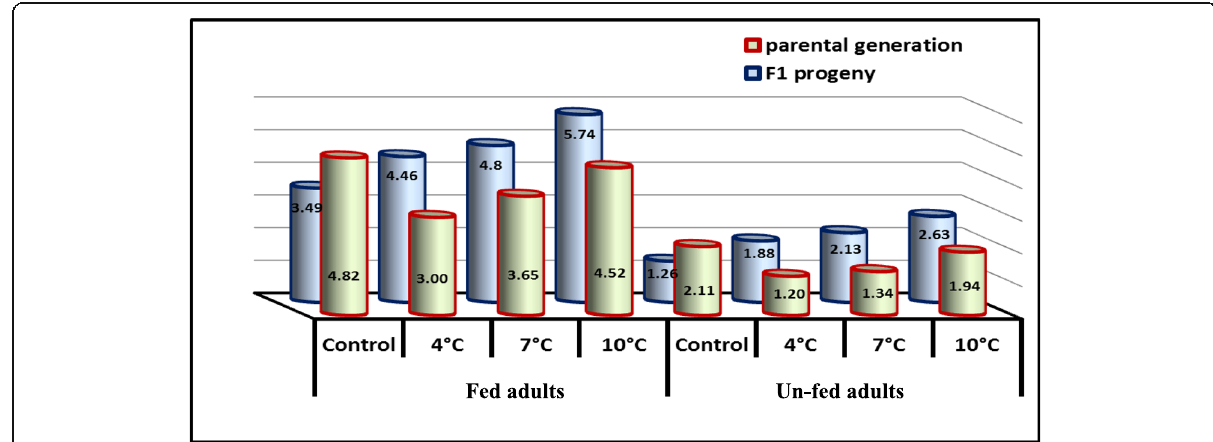
Fig. 1 Mean longevity of Trichogrammatoidea bactrae adults (fed and un-fed) of parental and F 1 progeny after storage of parasitoid larvae at different low temperatures